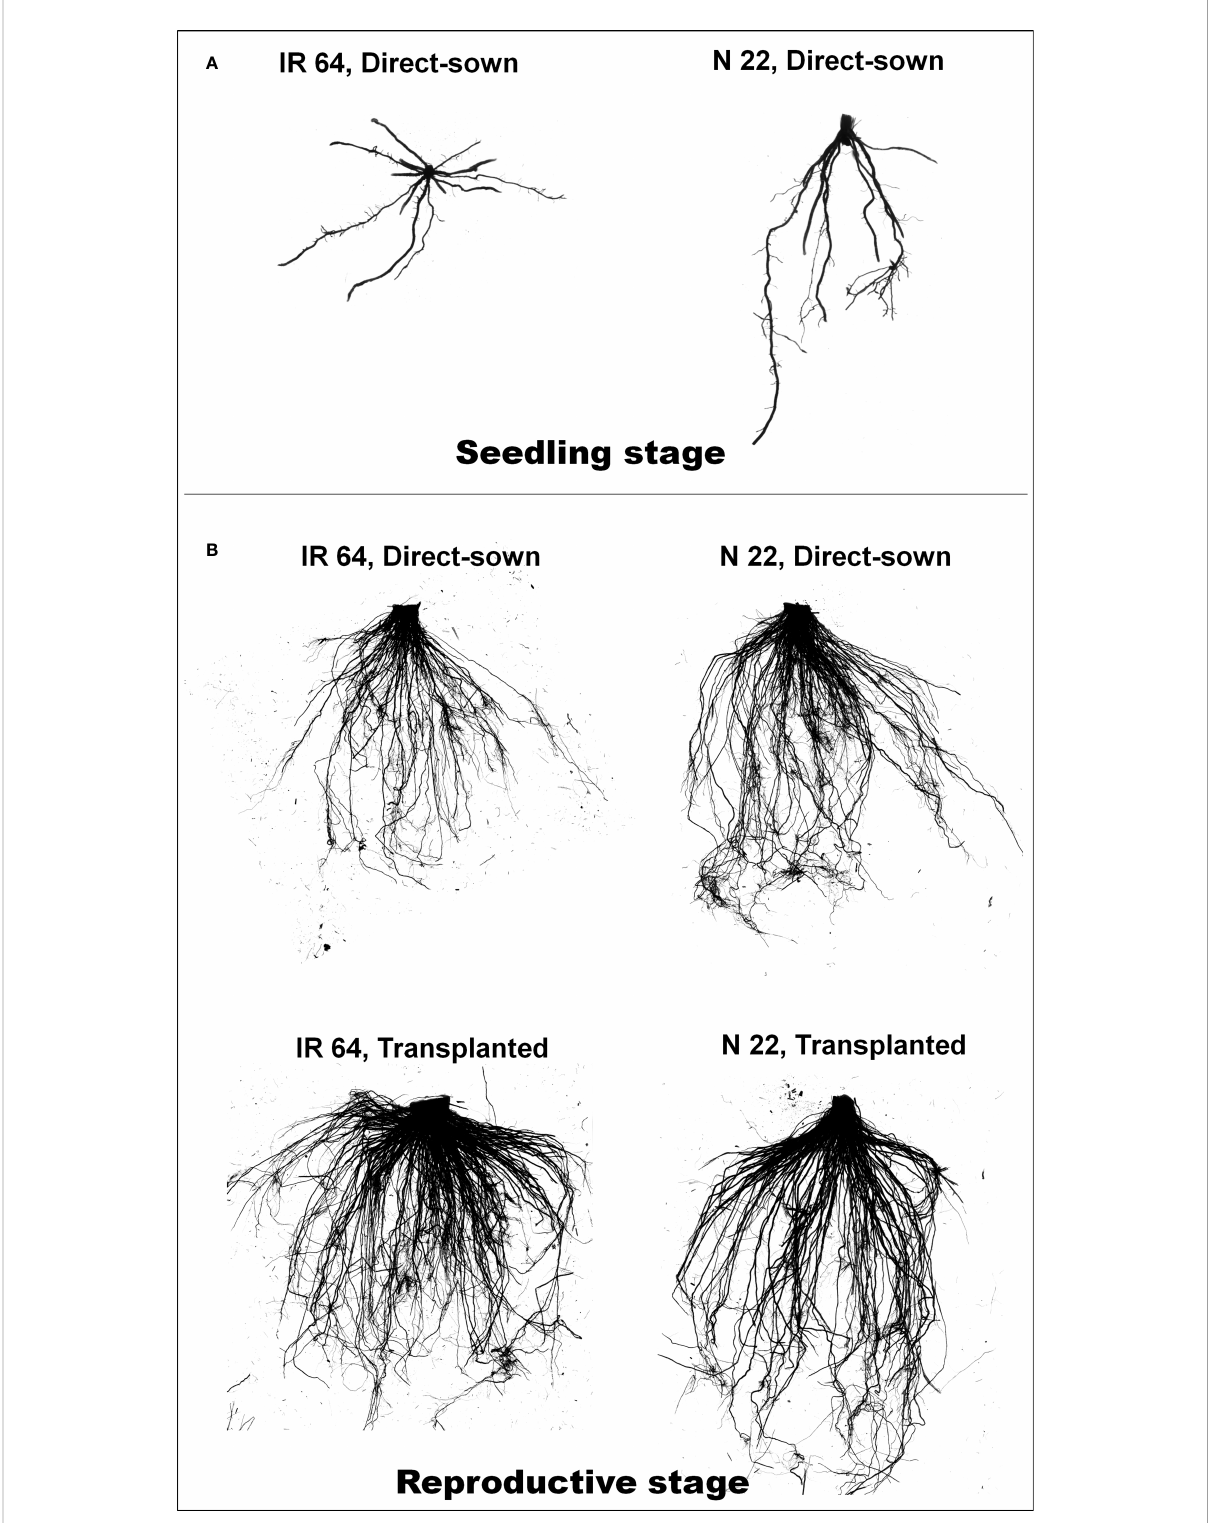
FIGURE 1 Representative pro fi les of root architecture of rice grown by different methods of planting. (A) Root of the seedlings grown by direct-sowing, (B) root of a plant [IR 64 and Nagina 22 (N 22)] at reproductive stage grown by different methods of planting